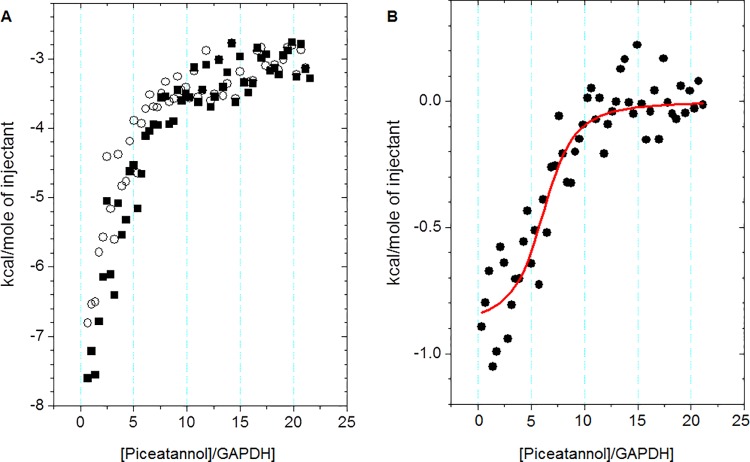
(A) Thermal effects of the titration 0.5 mM piceatannol solution (in the syringe) into 5 μM GAPDH protein solution (in the cell) (■) and corresponded to them thermal effects of dilution of the piceatannol in pure water (○). (B) Thermal effect of the interaction between protein GAPDH and piceatannol corrected with the piceatannol dilution effects and calculated per one mole of the ligand. Solid line is approximation of ITC date of GAPDH by piceatannol using the model of one set of binding sites.